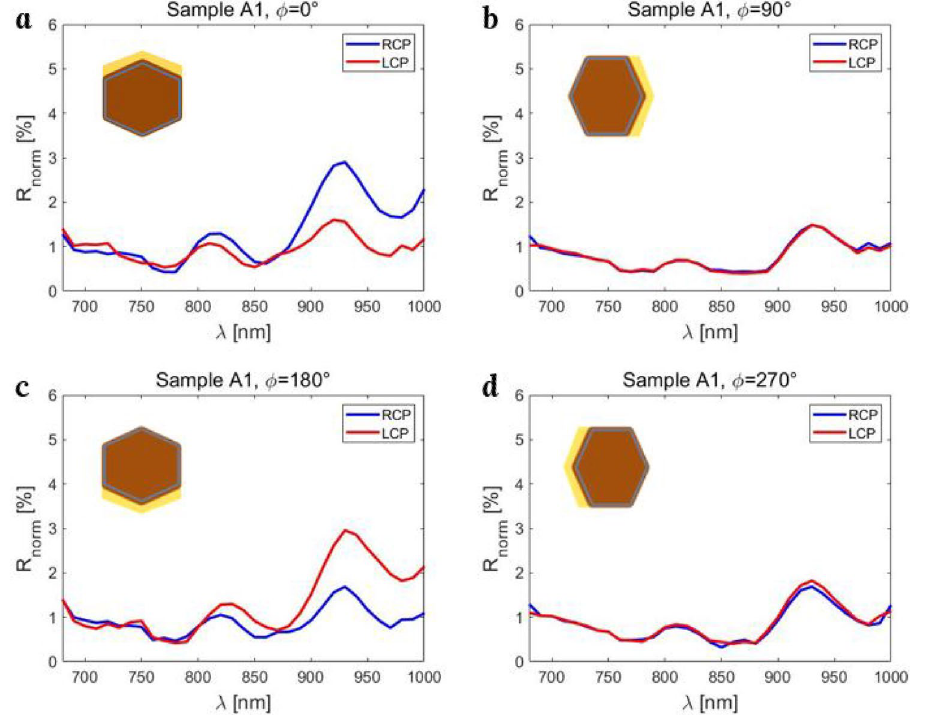
Figure 3. RCP and LCP reflection spectra for various orientations of Sample A1: ( a